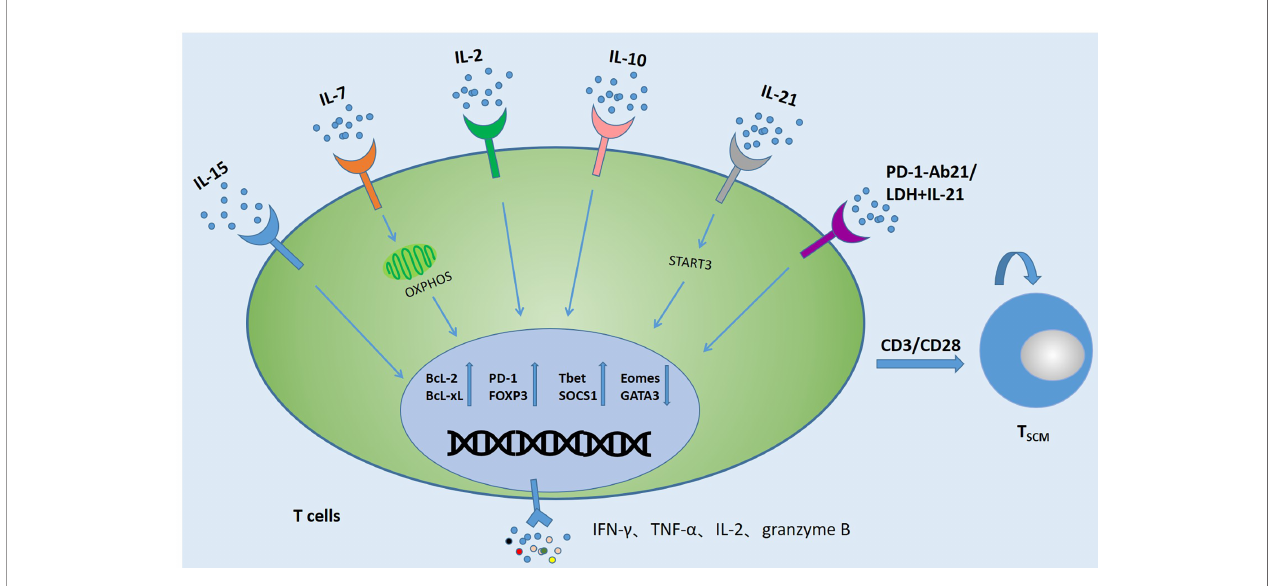
FIGURE 2 | Several strategies to induce the generation of T SCM . Activating T cells (CAR-T cells, TCR-T cells, TILs, VSTs) with anti-CD3/CD28 antibodies and co- cultivating them with cytokines or combined with PD-1 and LDH can promote the production of T SCM cells and change the expression levels of related anti-apoptotic proteins and metabolic molecules. In addition, the expression of TNF- a , IFN- g , IL-2 and Granzyme B also increased signi fi